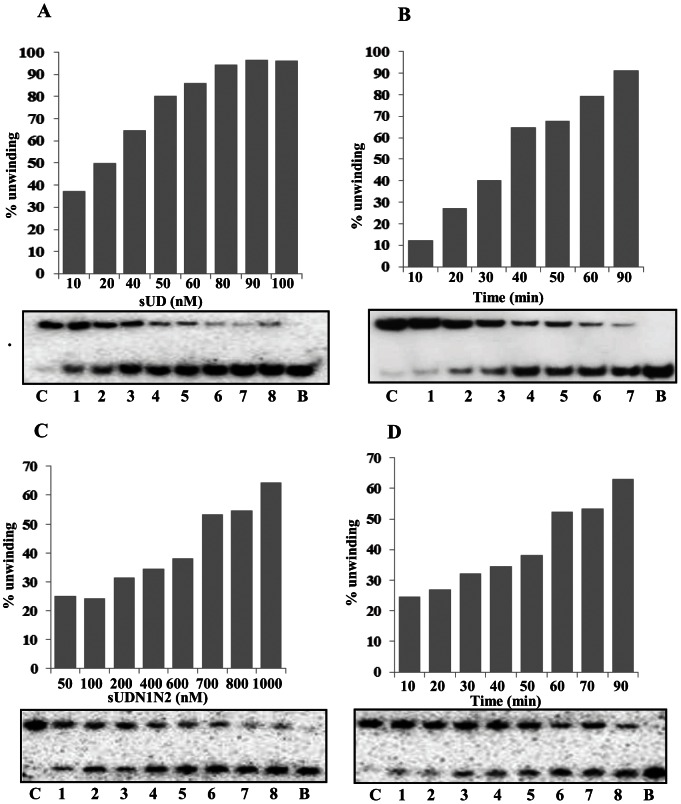
Analysis of helicase activity.A. Helicase activity of sUD. The quantitative enzyme activity data from the autoradiogram are shown and the concentration of sUD is also written on the X axis of the bar diagram. B. Time-dependence of helicase activity of sUD. The quantitative enzyme activity data from the autoradiogram are shown and the time is written on X-axis. C. Helicase activity of sUDN1N2. The quantitative enzyme activity data from the autoradiogram in C are shown and the concentration of sUDN1N2 is written on the X axis of the bar diagram. D. Time-dependence of helicase activity of sUDN1N2. The quantitative enzyme activity data from the autoradiogram are shown and the time is written on X-axis. In panels A–D, lane C is reaction without enzyme and lane B is heat denatured substrate. see also Figure S3 and S4.